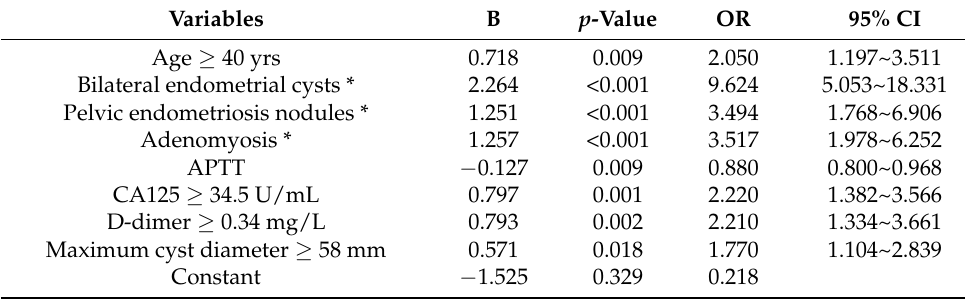
Table 6. Preoperative independent related factors of severe